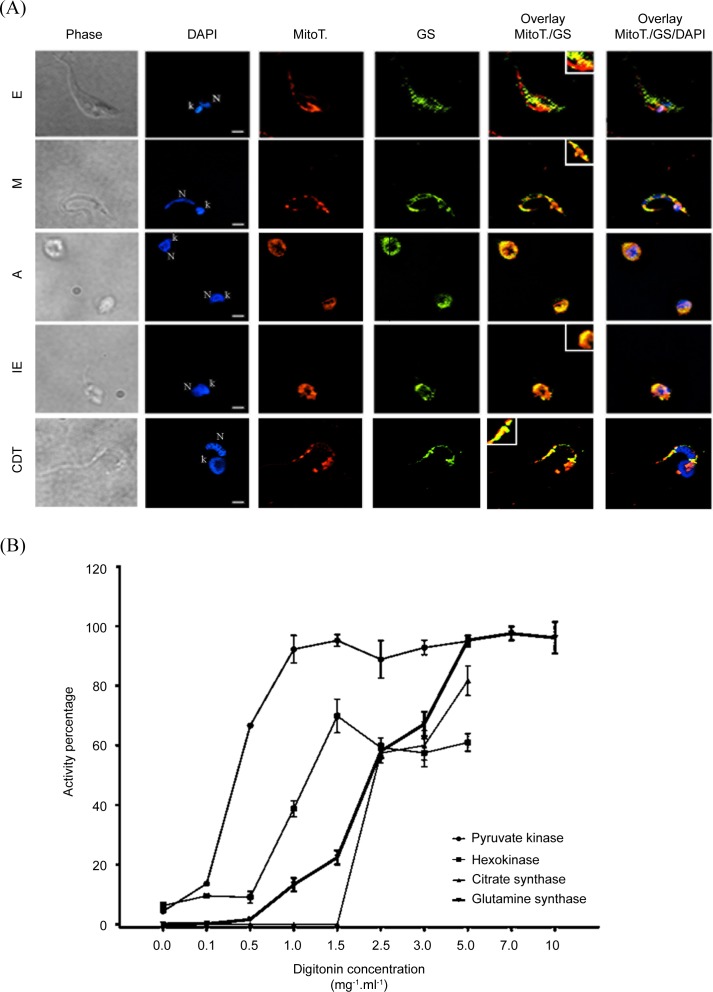
Subcellular localization of GS in T. cruzi.(A) All stages of T. cruzi life cycle (E–Epimastigote; MT–Metacyclic trypomastigote; A–Amastigote; IE–Intracellular epimastigote; and CDT–Trypomastigote) were harvested by centrifugation, immobilized on glass slides, incubated with anti-GS (green) and labeled with DAPI for DNA staining (blue) and MitoTracker Red Mito Sox for mitochondrial staining (red). Bars are 1 μm. N—nucleus, k–kinetoplast. (B) E were selectively permeabilized with increased digitonin concentrations (0–5 mg/ml), and the resulting supernatants (S) and pellets (P) were used for enzymatic assays. The enzymatic activities of pyruvate kinase (filled circles—cytosol marker), hexokinase (filled squares—glycosomal marker), citrate synthase (right-side up filled triangles—mitochondrial marker), and GS (upside-down filled triangles) were determined for all resulting fractions (S and P). The data correspond to the ratio between activities on S and P and were expressed as a percentage of the enzyme.